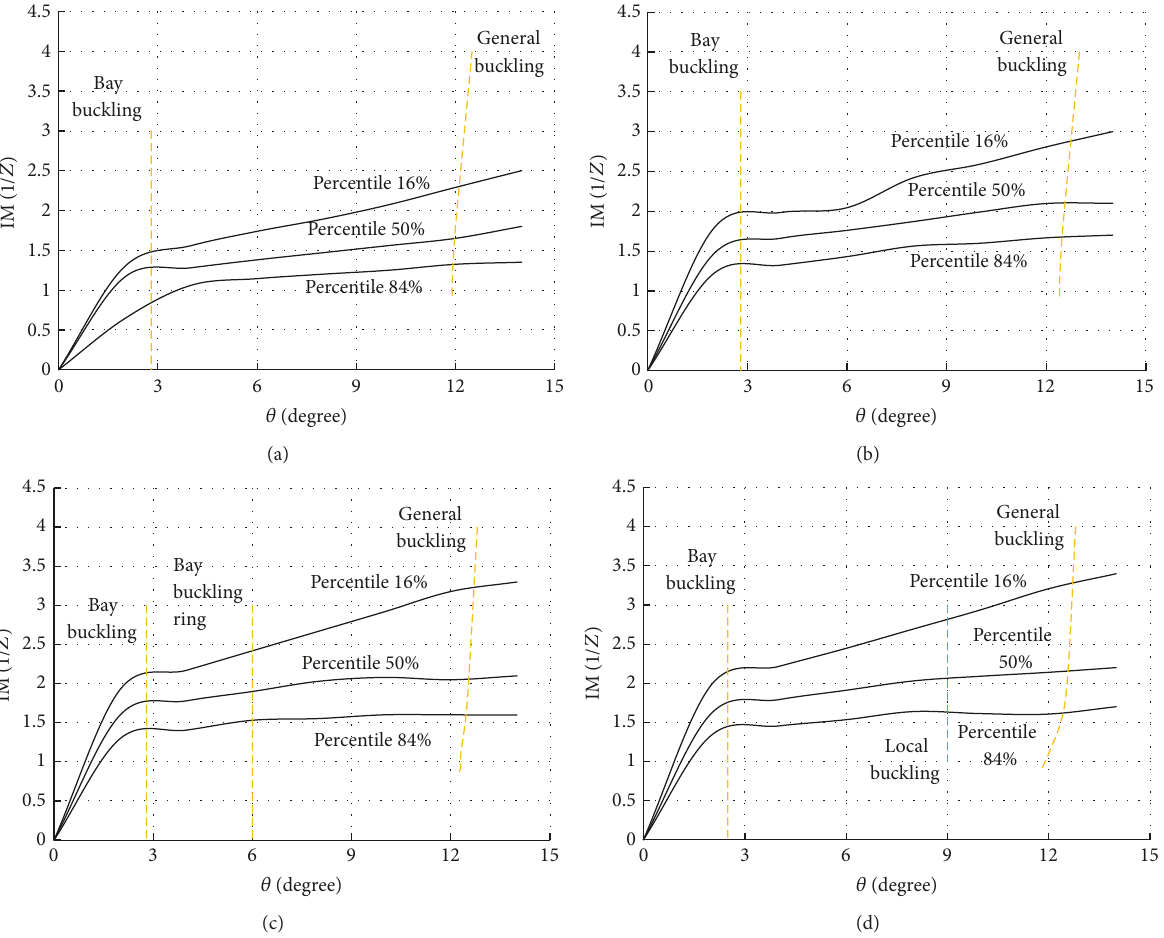
Figure 11: IEA curves of four different configurations with three percentiles including distinct limit states: (a) unstiffened shell, 4mm; (b) unstiffened shell, 6.5 mm; (c) ring-stiffened shell, 6.5 mm; and (d) ring- and longitudinal-stiffened shell, 6.5